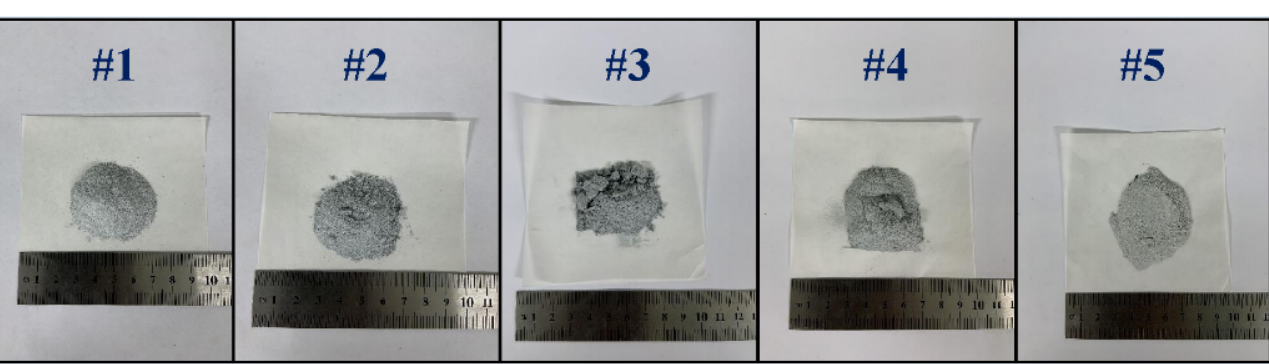
Figure 8. The residue after the reaction of different pellets.